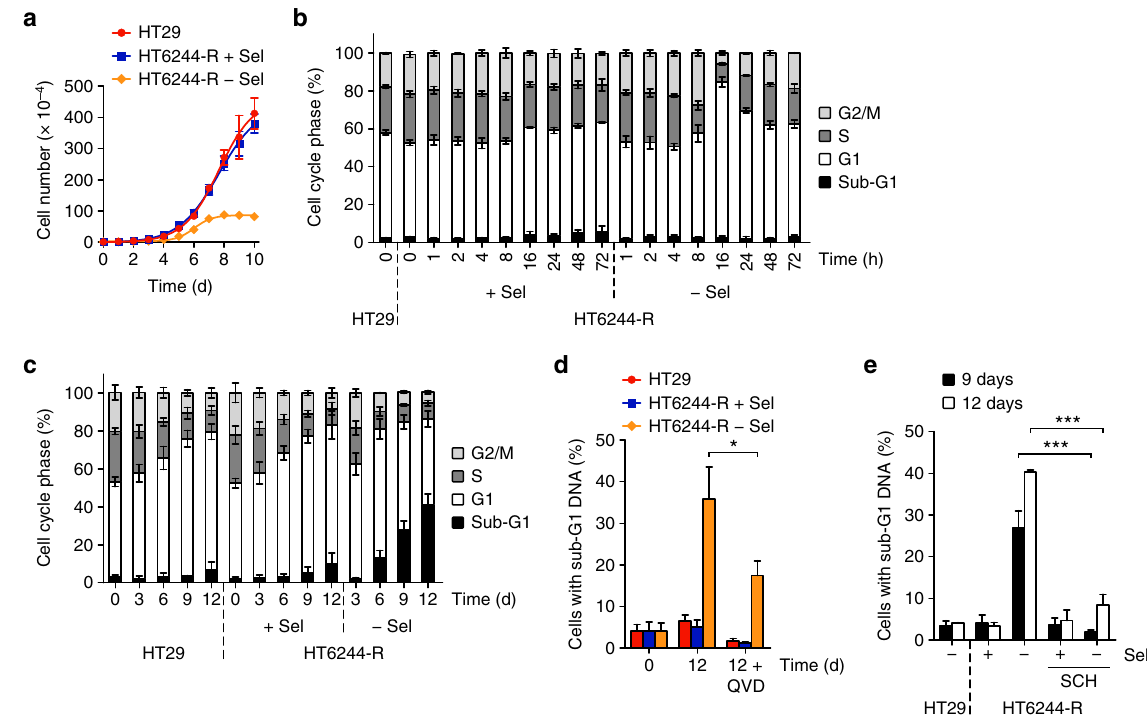
Fig. 3 MEKi withdrawal from BRAF V600E -ampli fi ed MEKi-resistant HT29 cells causes cell death. a HT29 and HT6244-R cells were treated with either 1 μ M selumetinib (HT6244-R + Sel) or DMSO only (HT29, HT6244-R − Sel) and cell numbers counted over 10 days. Results are mean ± SD of cell culture triplicates, representative of two experiments. b , c HT29 and HT6244-R cells were treated with either 1 μ M selumetinib (HT6244-R + Sel) or DMSO only (HT6244-R − Sel) for the indicated times, and cell cycle distribution determined by fl ow cytometry. d HT29 and HT6244-R cells were treated with 1 μ M selumetinib (HT6244-R + Sel) or DMSO only (HT29, HT6244-R − Sel), with or without 10 μ M Q-VD-OPh (Q-VD) for up to 12 days, and sub-G1 fraction determined by fl ow cytometry. P < 0.05 (*) determined by unpaired two-tailed t -test. e HT29 or HT6244-R cells were treated with 1 μ M selumetinib (Sel; + ) or DMSO only ( − ), with or without 0.1 μ M SCH772984 (SCH) for 9 or 12 days, and sub-G1 fraction determined by fl ow cytometry. P < 0.001 (***) determined by one-way ANOVA with Tukey ’ s multiple comparisons test. b – e Results are mean ± SD of three independent